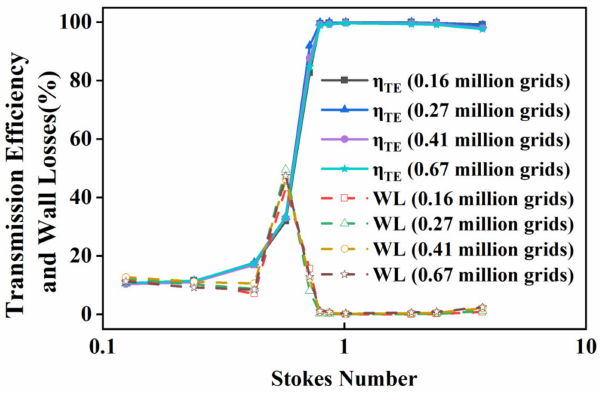
Figure 4. Sampler performance curve with different grid